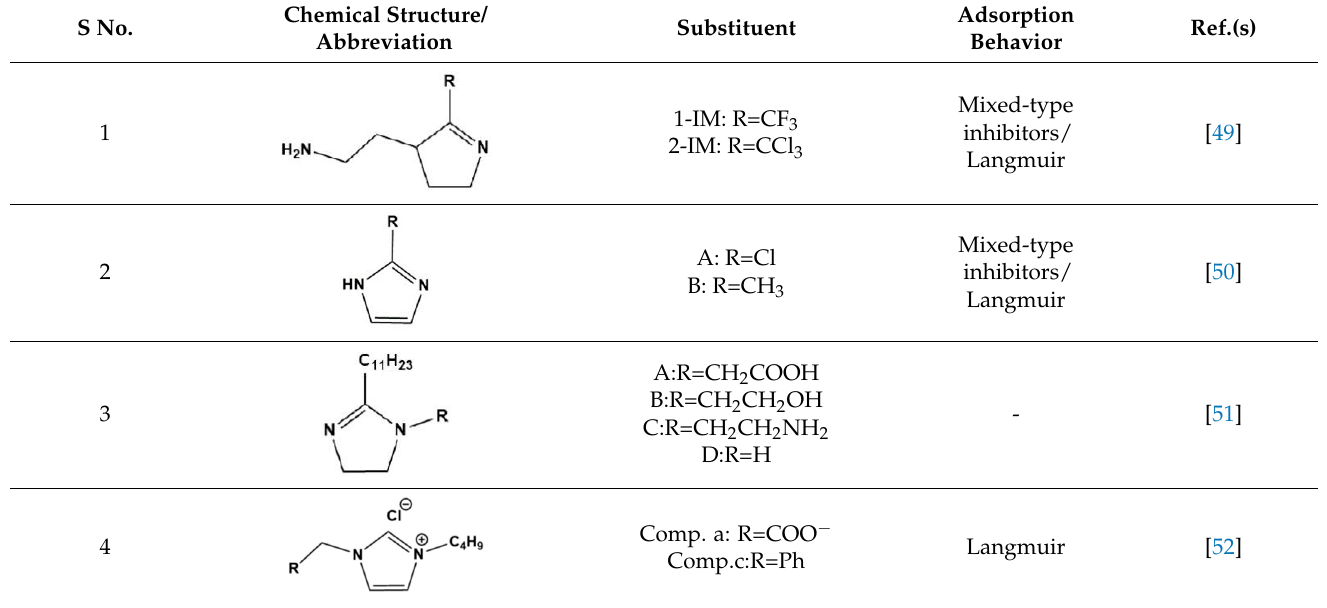
Table 2. Structural formulas of N-heterocycles with different electron-withdrawing and electron- donating groups.